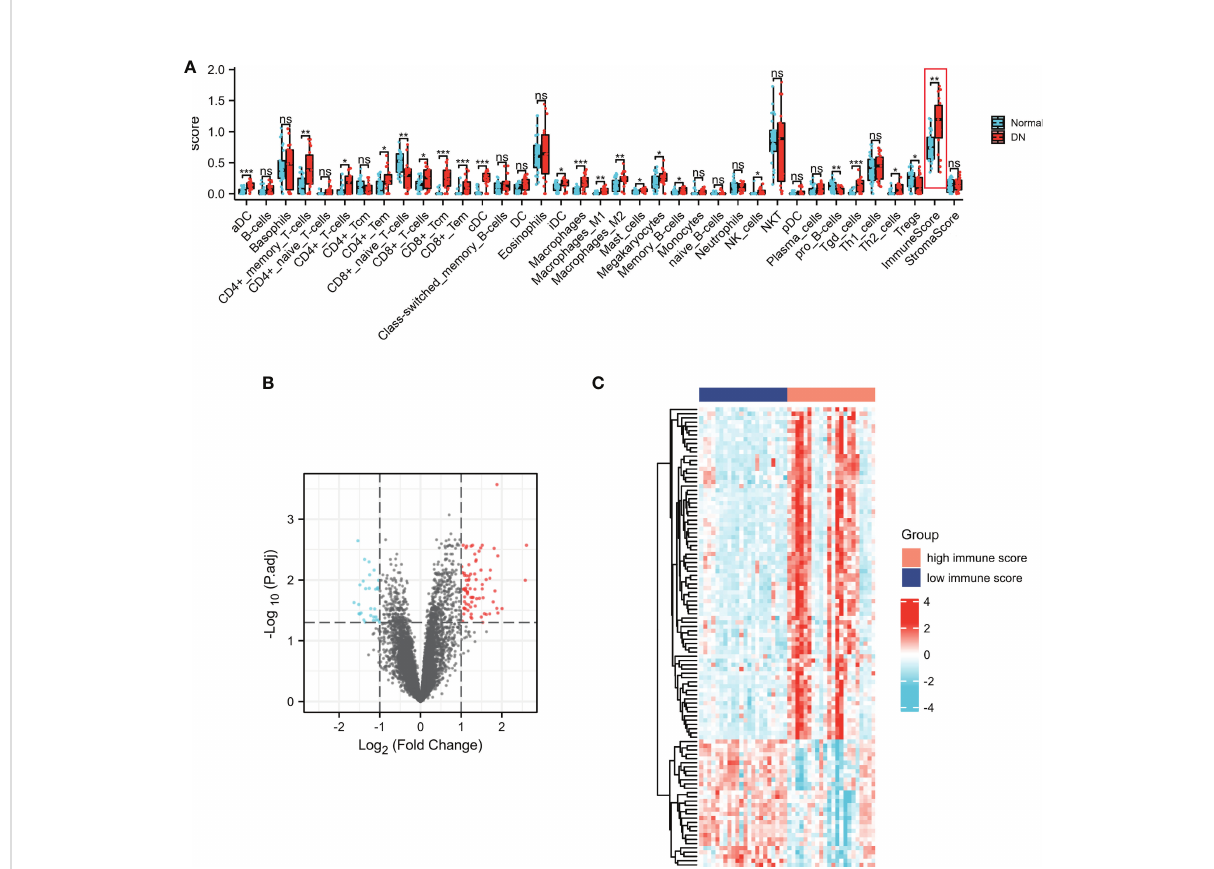
FIGURE 3 Characterization of the immune cell in fi ltrations in DN and identi fi cation of ISRGs. (A) The comparisons of the immune cell in fi ltration level between DN and normal groups. Volcano (B) and heatmap (C) plots of the ISRGs. For the volcano, the blue dots indicated the down-regulated genes and the red dots indicated the up-regulated genes. For the heatmap, the red group is the high immune score group, while the dark blue group is the low immune score group. The down-regulated genes are presented in blue, and up-regulated genes are presented in